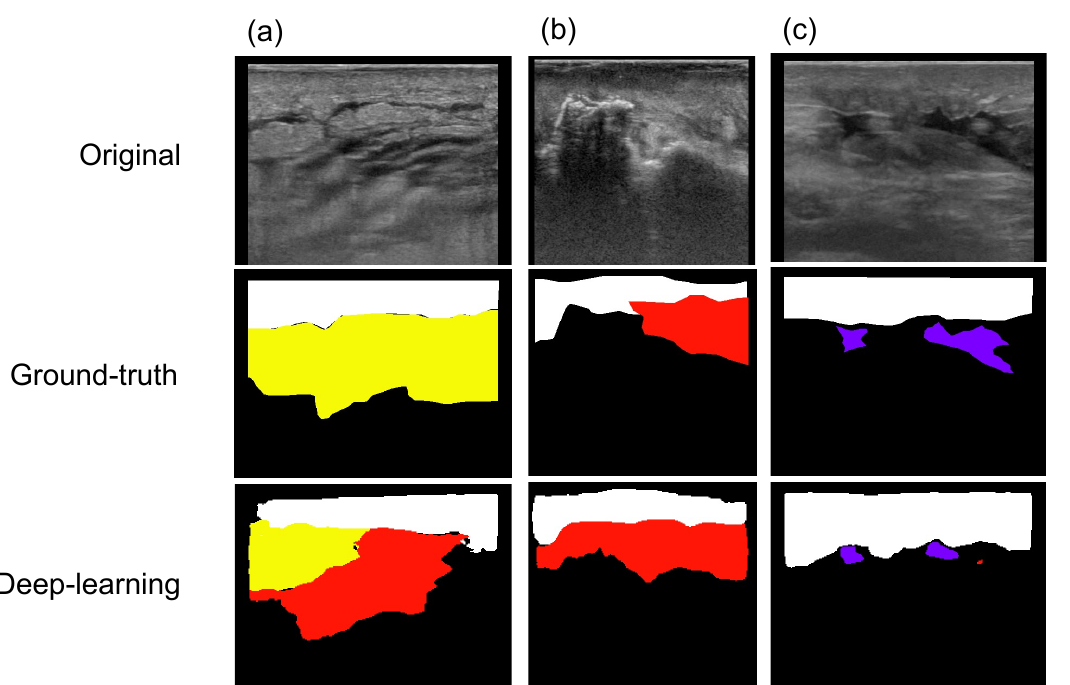
Figure 4. Examples of failed results of automatic classification based on deep learning. ( a ) Cobblestone-like pattern. ( b ) Cloud-like pattern. ( c ) Anechoic pattern. The “ground-truth” images show the regions that were manually annotated by the expert. The “deep-learning” images show the regions extracted as a result of automatic classification. White indicates an unclear layer structure, yellow indicates a cobblestone-like pattern image, red indicates a cloud-like pattern image, and purple indicates an anechoic pattern image. The values of the intersection over union (IoU) are, from left to right, 0.27, 0.42, and 0.27. Table 1. Results of the test for each ultrasonographic finding.